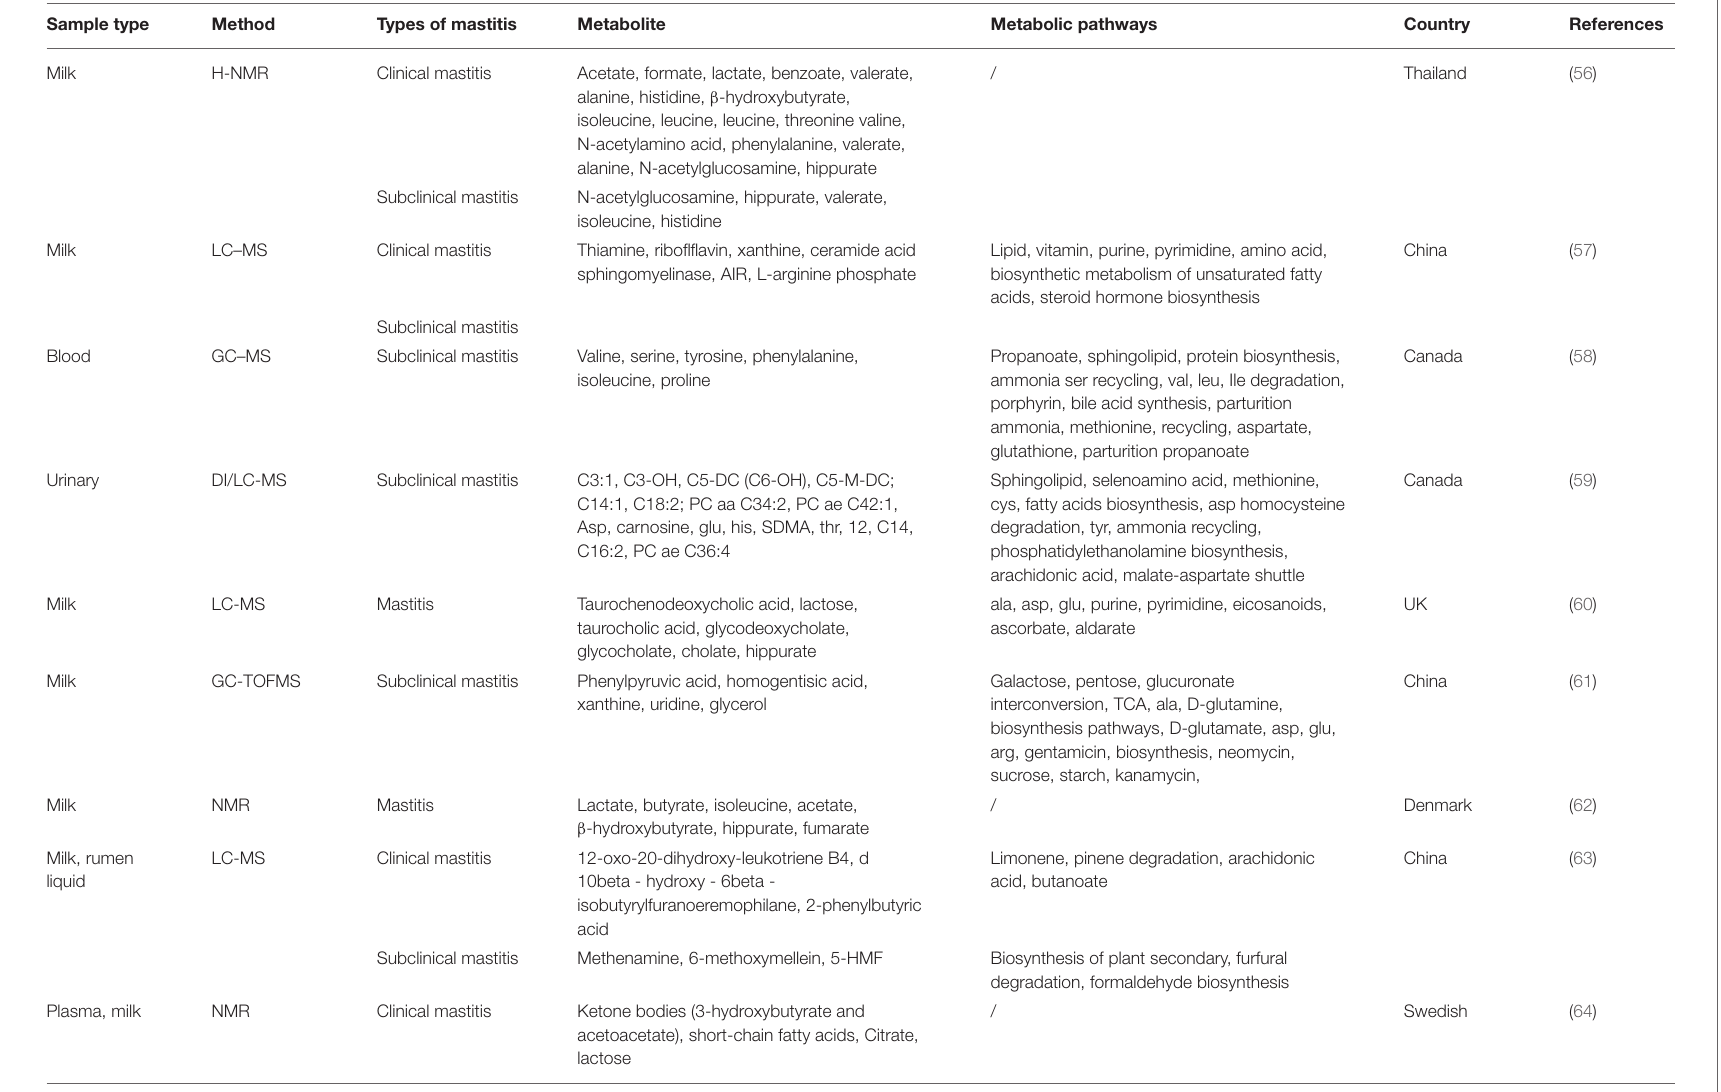
TABLE 2 | Research on dairy cow mastitis through metabolomics in various countries. Sample